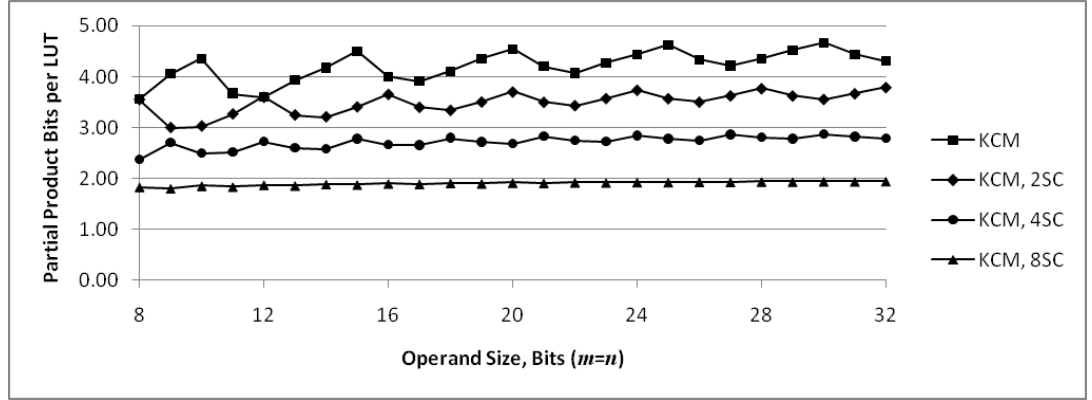
Figure 13. Number of partial product bits computed and summed per LUT6 for KCMs with one, two, four and eight coefficients, m = n